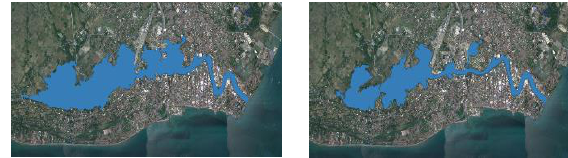
Figure 4. Delineated study area (blue polygon) from 1994 (left) and 2019 (right) satellite images